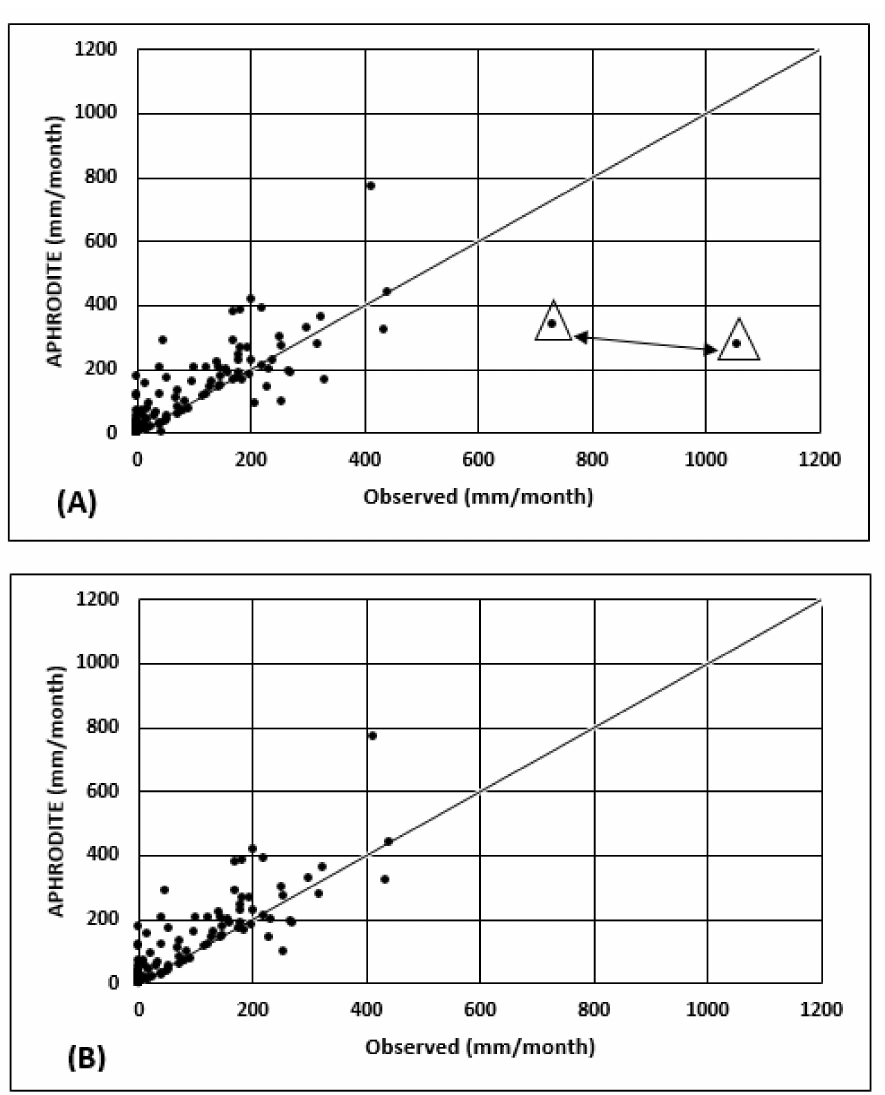
Figure A1. ( A ) Scatter plot between APHRODITE and observed rainfall between 2004 and 2014. ( B ) Same as the above, but during